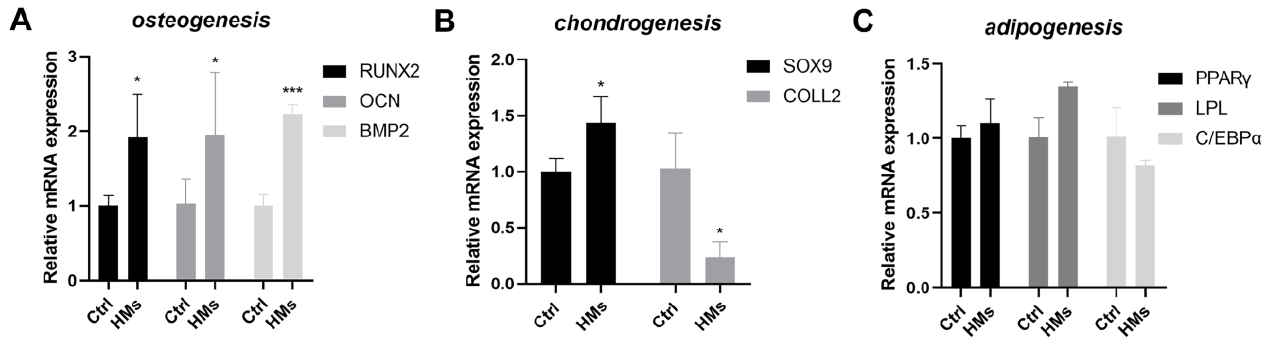
Figure 3. The effect of HMs on bone marrow mesenchymal stem cells . ( A ) The expression of osteogenic marker genes (RUNX2, OCN, and BMP2). ( B ) The expression of chondrogenic marker genes (SOX9 and COLL2). ( C ) The expression of adipogenic marker genes (PPARγ, LPL, and C/EBPα). (Error bars, mean ±SD; ∗ p < 0.05, ∗∗∗ p < 0.001; n = 3 per group).